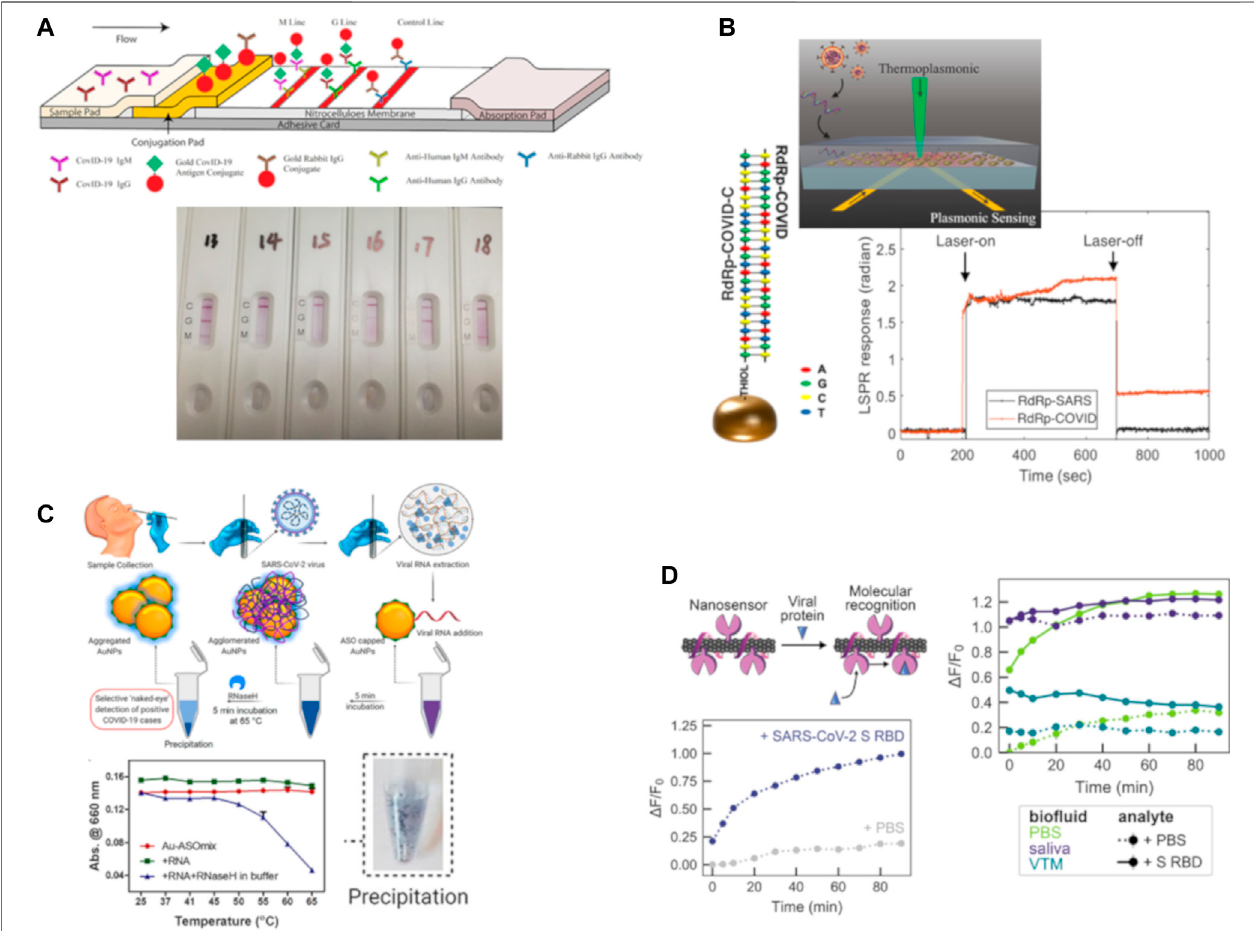
FIGURE 3 | Representative examples of optical nanosensors for COVID-19 detection. (A) A lateral fl ow immuno-assay (LFIA) test strip, combined testing for both